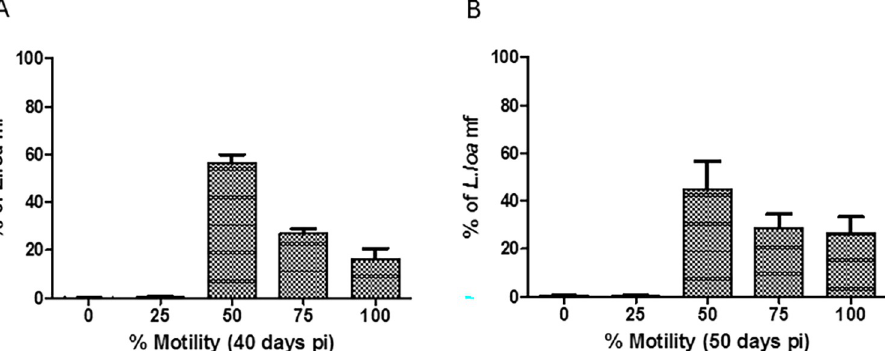
Fig 6. Percentage motility of peritoneal L . loa mf in gerbils. Day post infection (A) 40 days, and (B) 50 days.